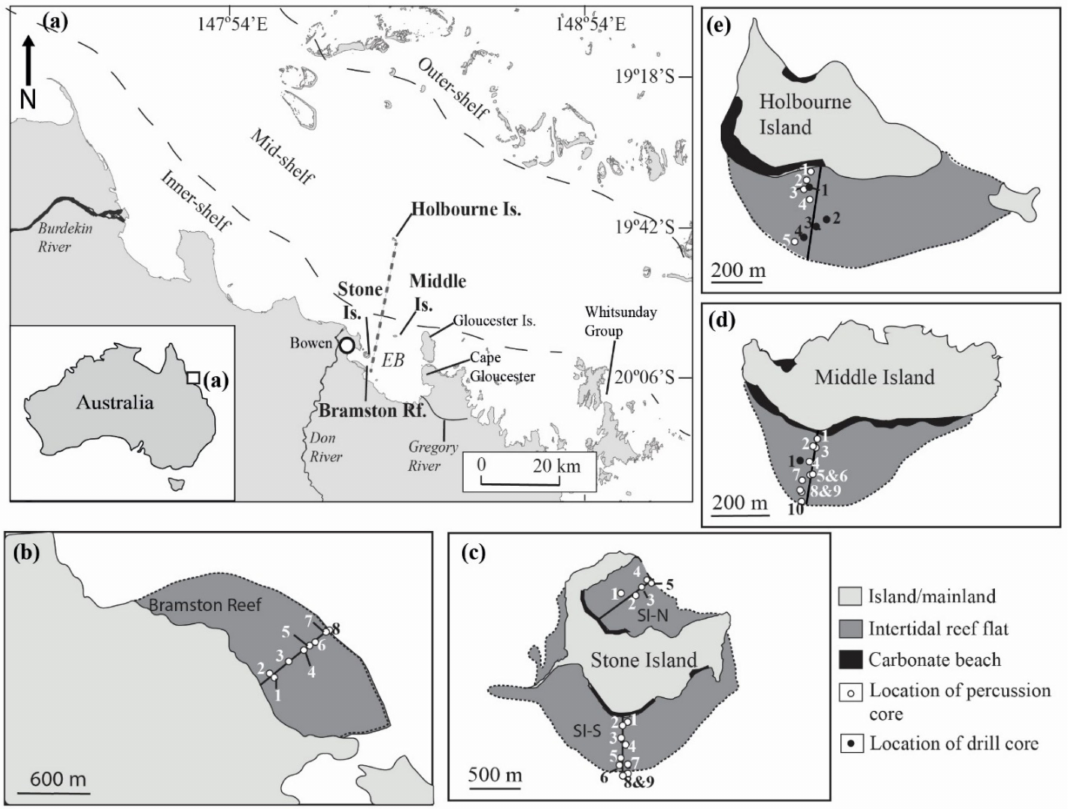
Figure 1. ( a ) Location of study sites and Edgecumbe Bay (EB) in Queensland, Australia. ( b – e ) Location of percussion core and drill core samples (numbered) at ( b ) Bramston Reef, ( c ) Stone Island North (SI-N) and South (SI-S), ( d ) Middle Island, and ( e ) Holbourne